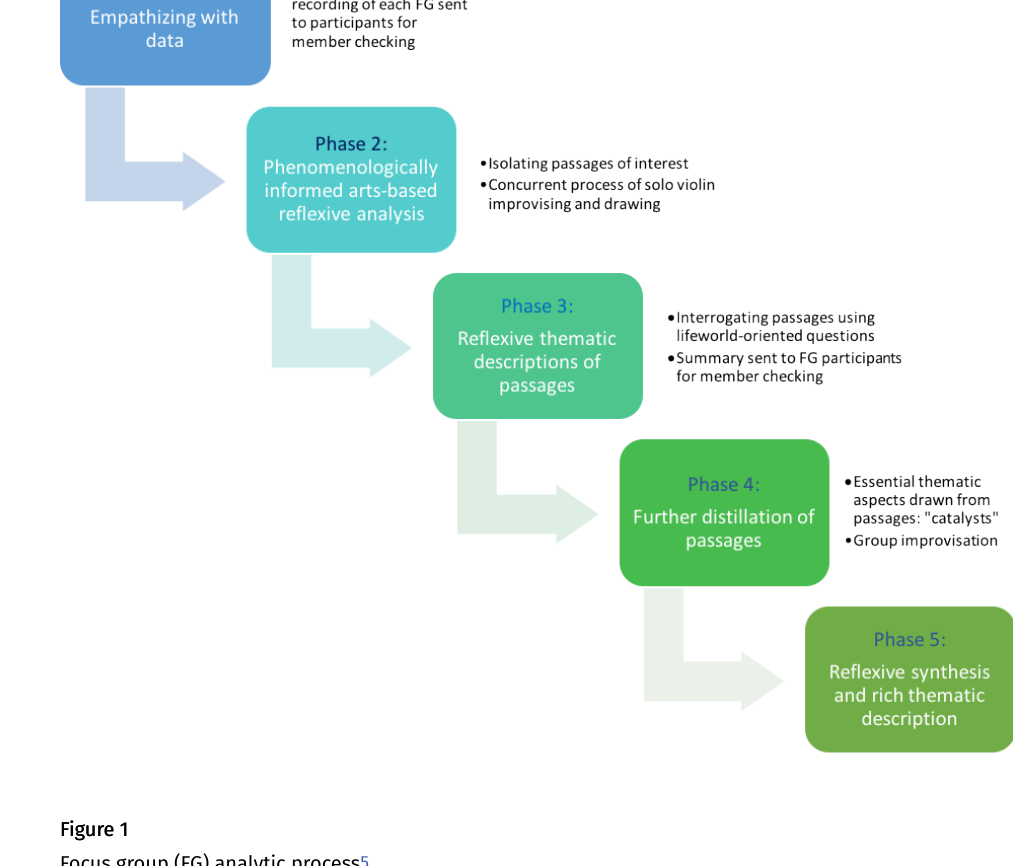
Focus group (FG) analytic process